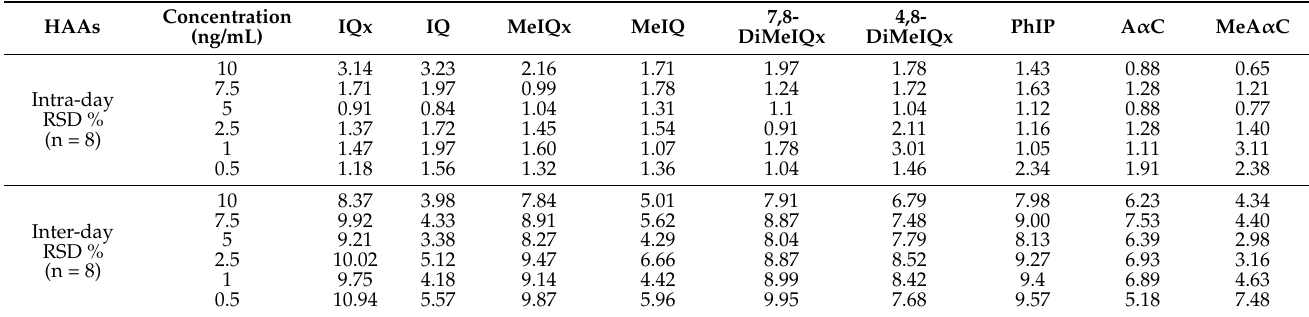
Table 4. The relative standard deviation (RSD%) of different heterocyclic aromatic amines in blank milk analyzed at six different concentrations.